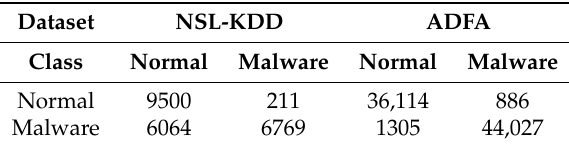
Table 14. Confusion matrix results for Stage